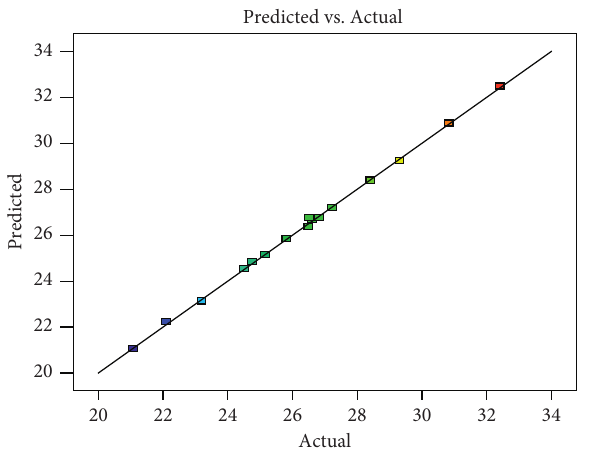
Figure 2: The predicted and actual